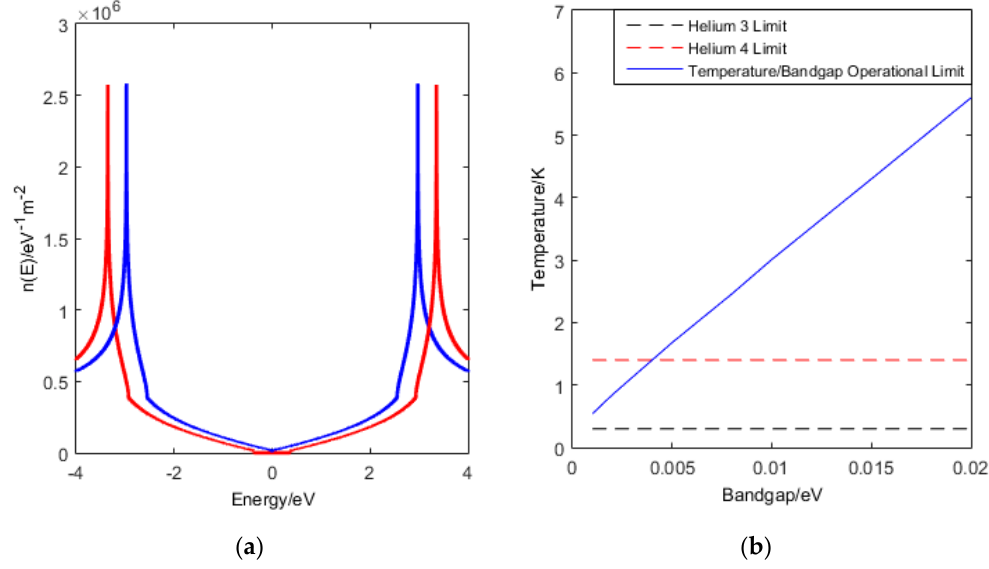
Figure 2. Showing ( a ) the density of states for bilayer graphene with a band gap of 5 meV; red is the σ band, blue is the π band. ( b ) shows the o perational limit of a bilayer graphene photodetector. In this simulation, A = 1 mm 2 . Helium-4 cooling limit is 1.4 K and Helium-3 limit is 0.3 K.